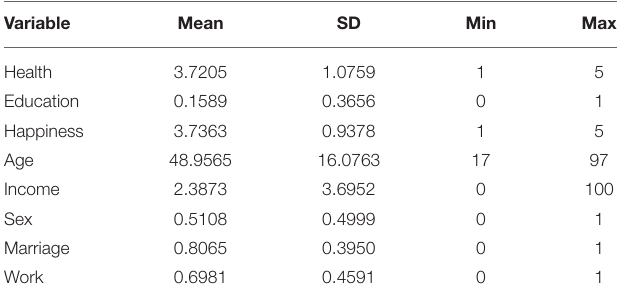
TABLE 1 | Descriptive statistics of the main variables.